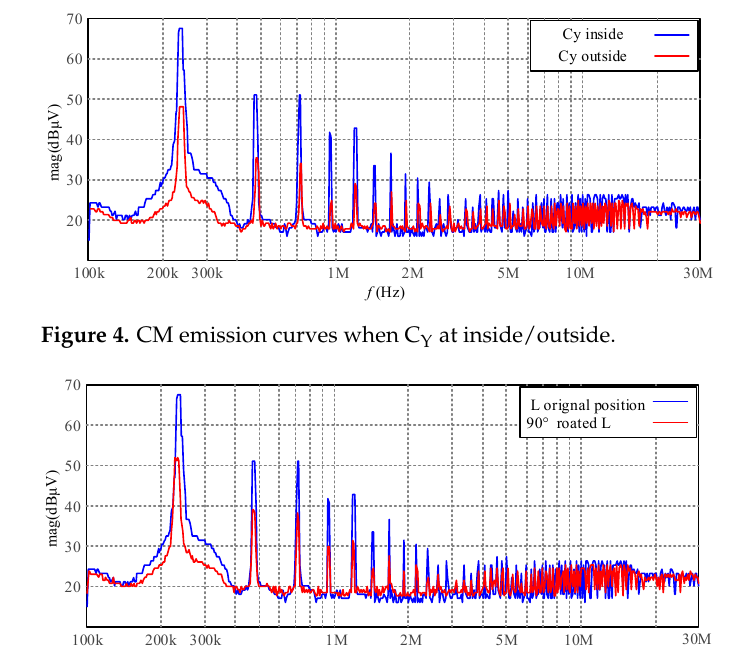
Figure 3. Schematic diagram of changing C Y and L position.